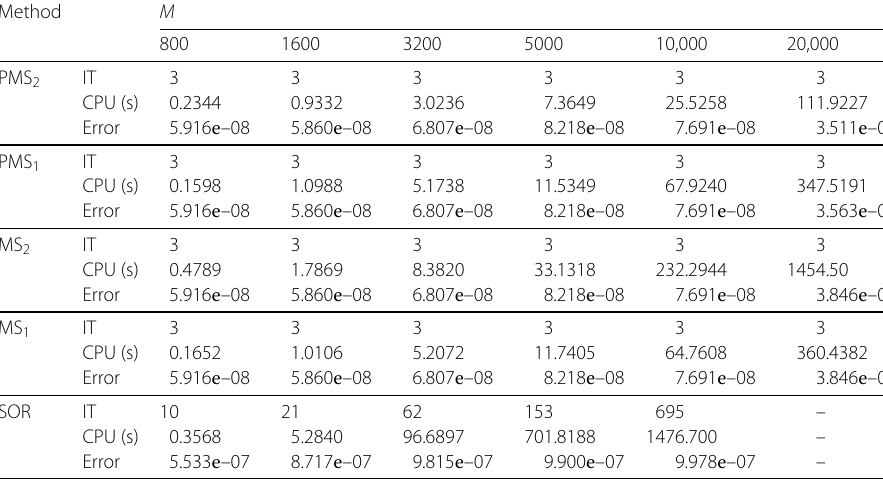
Table 2 Numerical results of the Example 1 for α =